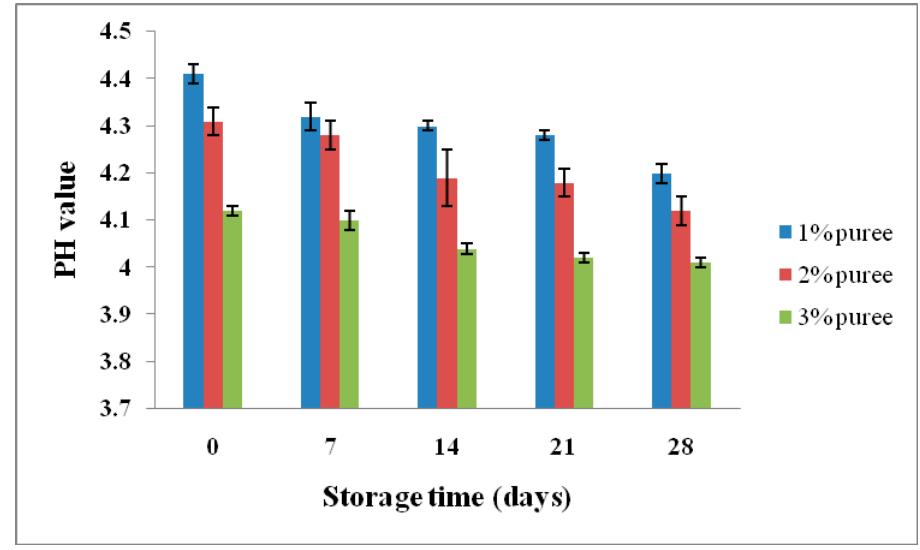
Figure 1. Influence of pineapple puree on goatmilk yogurt during storage.